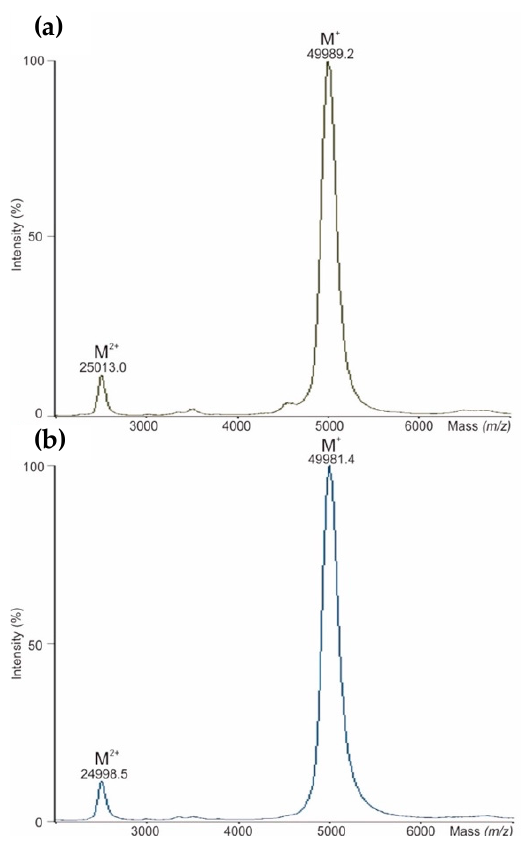
Figure 1 . ( a ) Matrix-assisted laser desorption ionization time of flight mass spectrometry (MALDI-TOF-MS) analysis of intact mass for NovoSeven ® , and ( b ) for AryoSeven™.